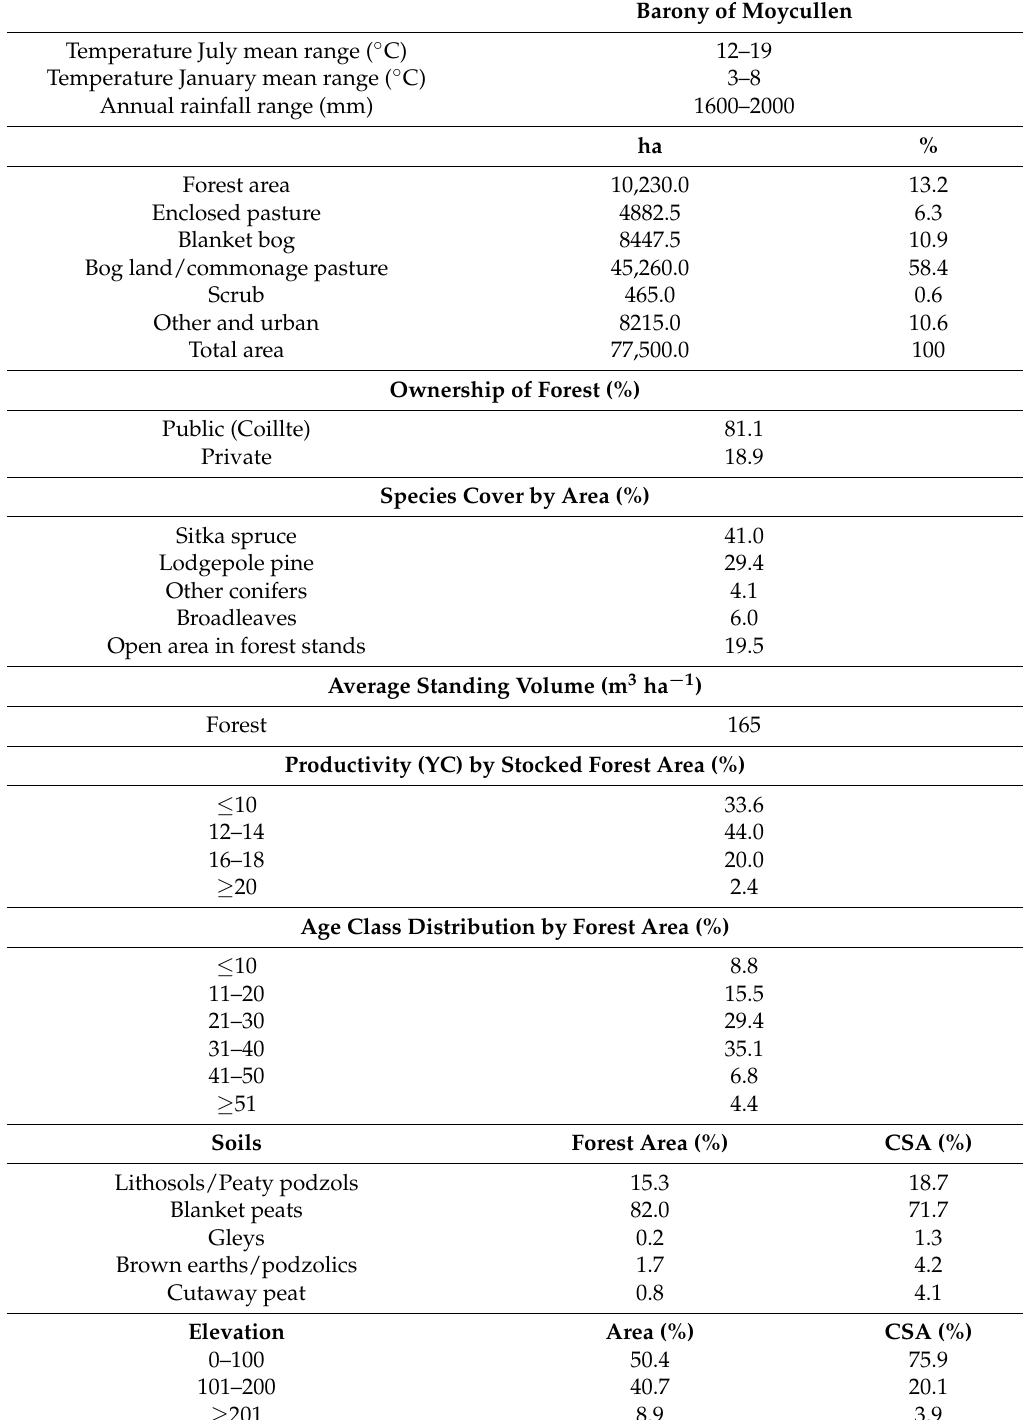
Table 1. Descriptive statistics for the case study area relating to climate (1981–2010), land-use, and forest data. Climate data from [37], land-use, forest, and soil data from the GIS sources listed in Table